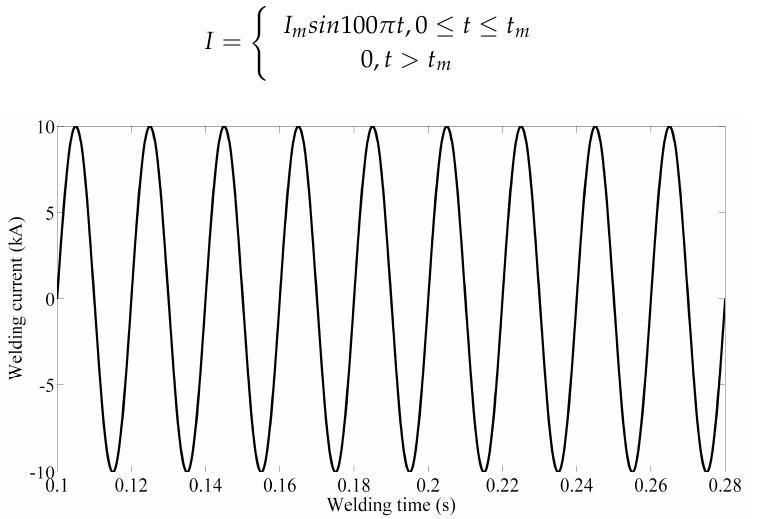
Figure 9. The waveform of welding current.